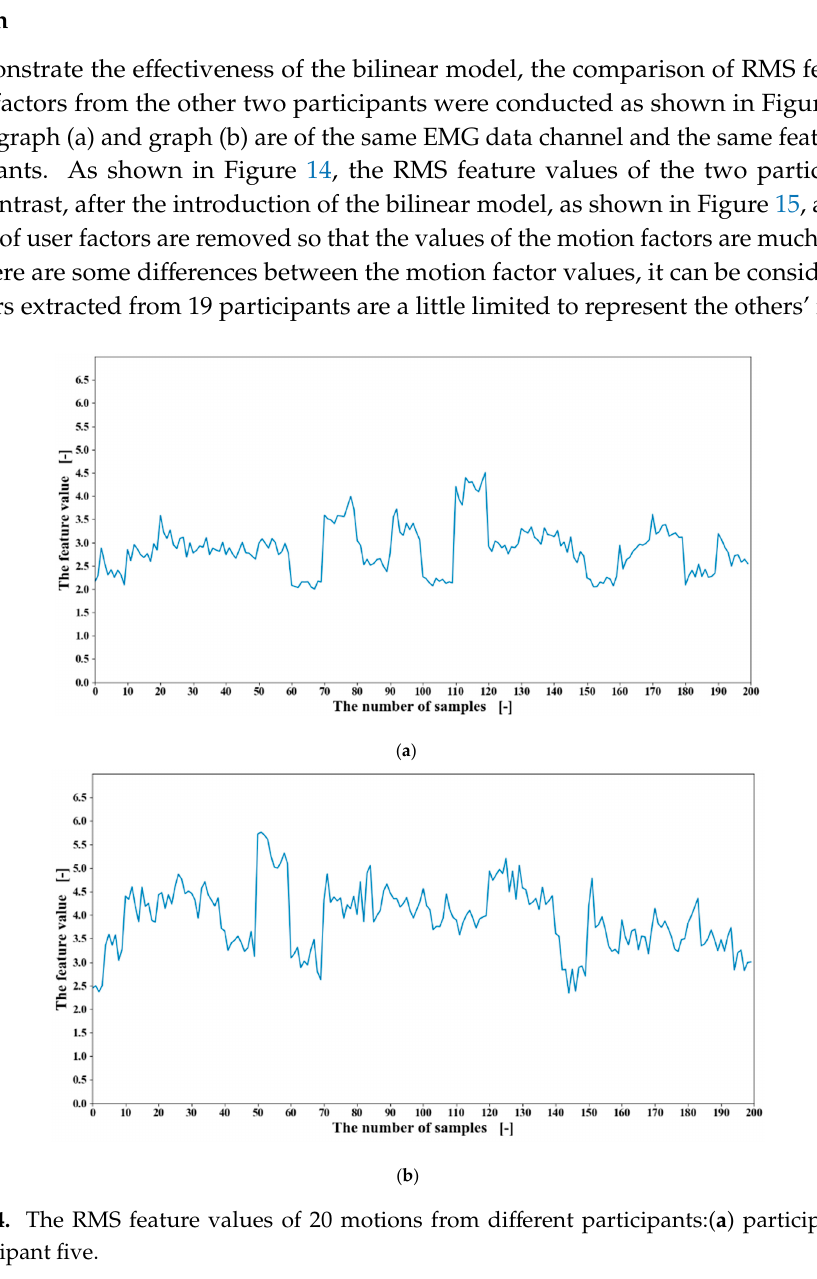
Table 9. The classification accuracy of 20 participants with the bilinear model.